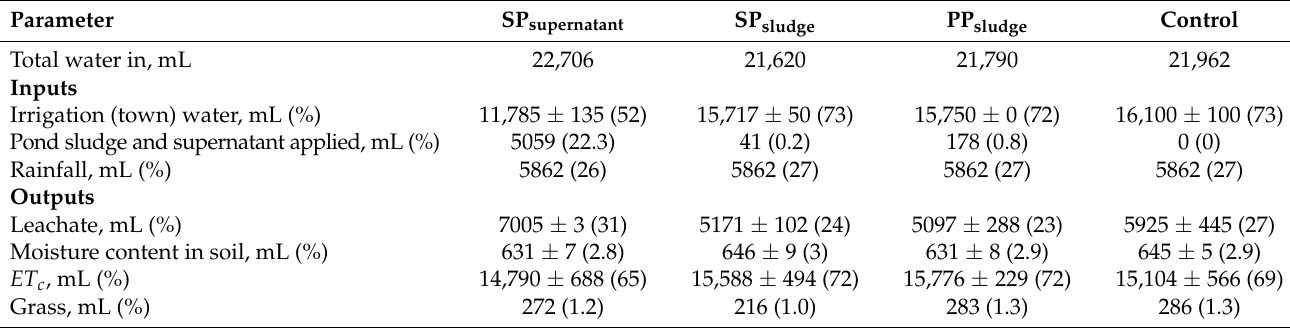
Table 4. Overall water balance for the pots.